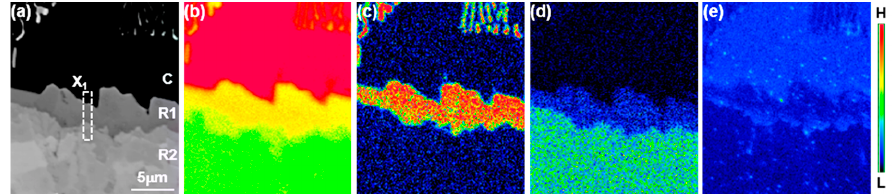
Figure 5. EPMA analysis results of reaction layers near the original steel interface in sample that was hot-dipped at 690 ◦ C for 120 s: ( a ) BSE Image; ( b ) Al; ( c ) Ni; ( d ) Fe; ( e )